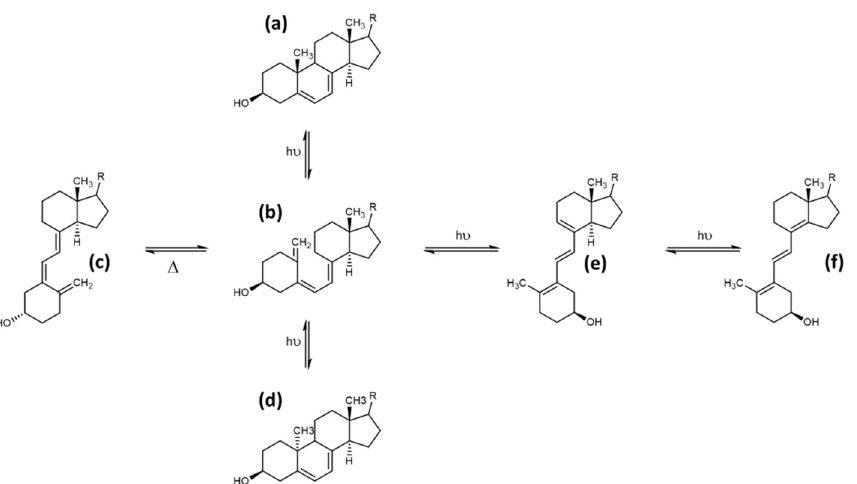
Figure 6. UV B-induced transformations of provitamin D to previtamin D, and consequently to vitamin D, lumisterol, and tachysterol. Provitamin D ( a ) is transformed by UV-light to previtamin D ( b ), followed by a thermally activated trans isomerisation to generate vitamin D ( c ). Alternative phototoinduced pathways are the formation of lumisterol ( d ) from previtamin D by ring-closure or the formation of tachysterol ( e ), and, after a second photoinduced isomerisation, iso- tachysterol ( f ).